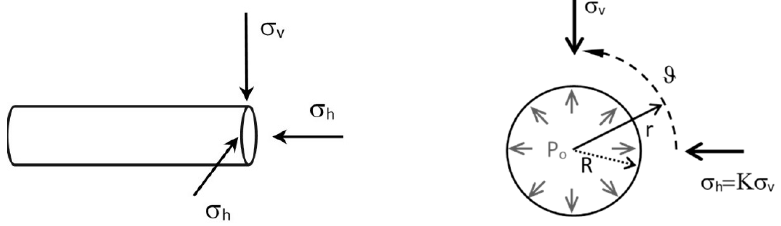
Figure 3. Far field stresses ( σ v , σ h ), radial distance ( r ), tunnel radius ( R ), azimuth ( ϑ ), and support pressure ( P o ) in a horizontal circular tunnel.